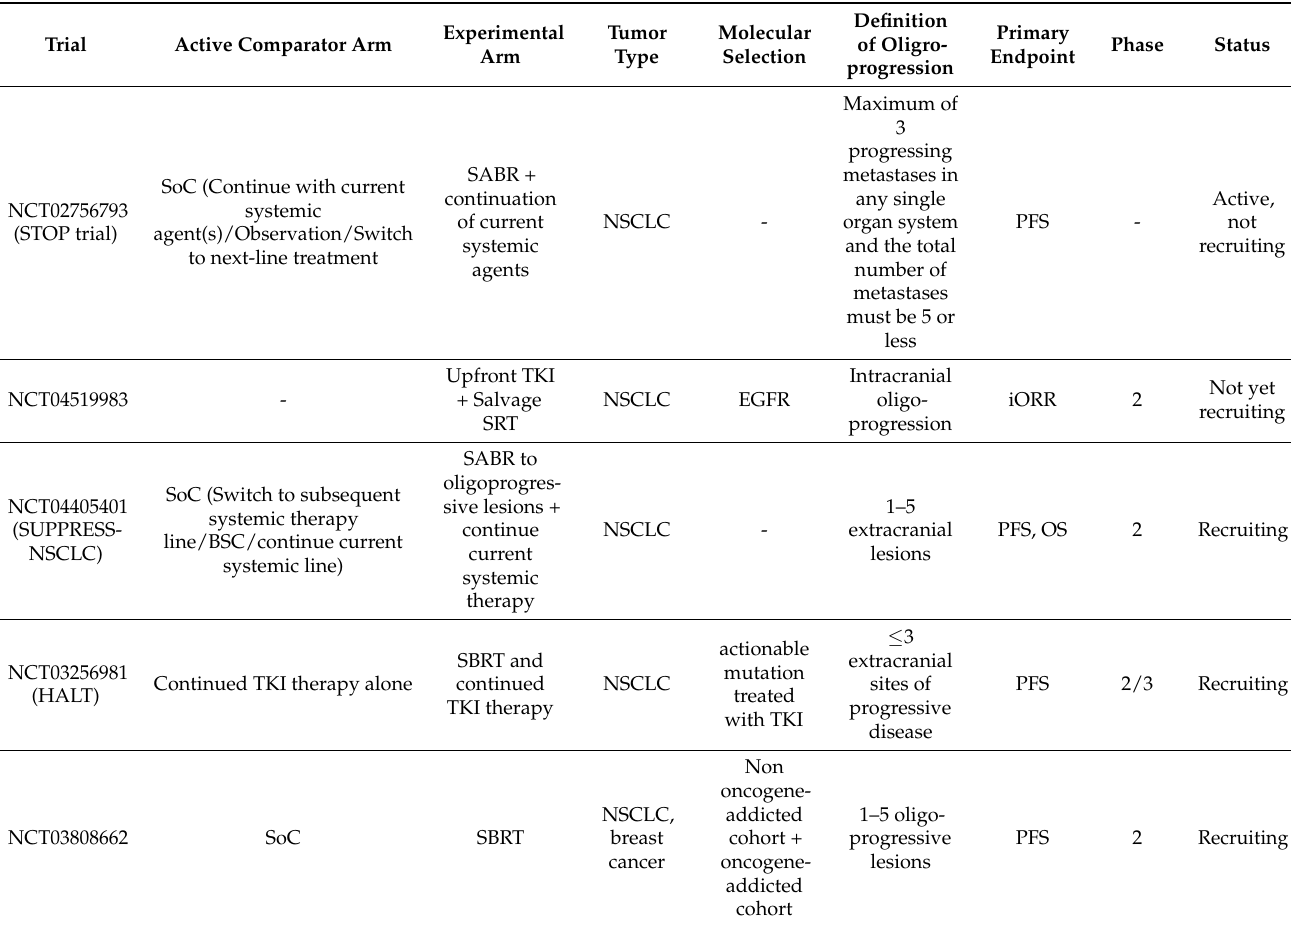
Table 2. Main ongoing clinical trials in oligoprogressive